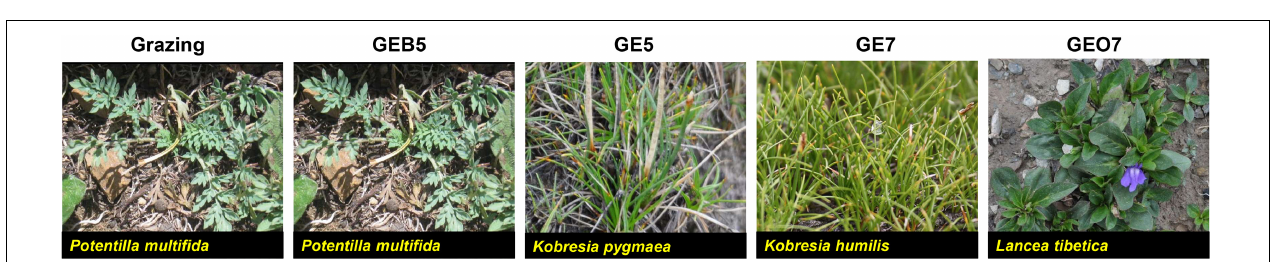
FIGURE 5 | Changes of the average connectivity (A) and average clustering coefficient (D) of the plant community along a grazing exclusion gradient. The relationship between these two indexes with species richness (B,E) and aboveground biomass (C,F) of plant communities was fitted by a quadratic and linear model, respectively.